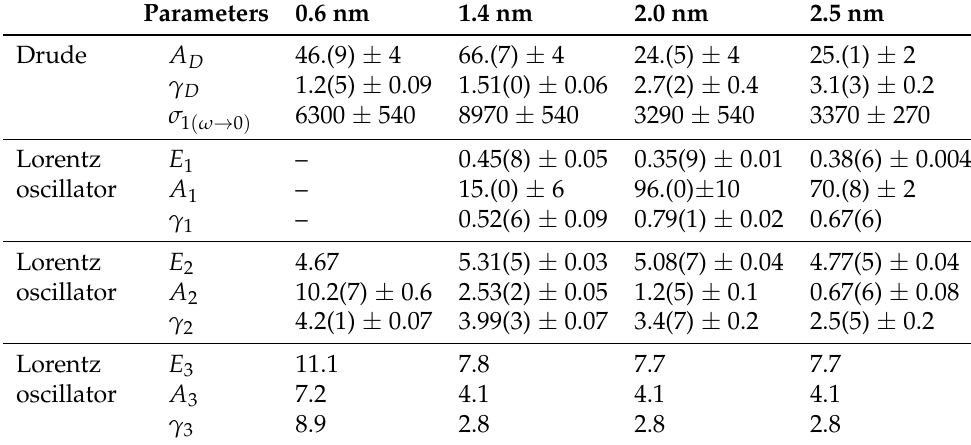
Table 1. Drude–Lorentz parameters for the Bi spacer layer in the [Bi(0.6,1.4,2.0,2.5nm)–NiFe(1.8nm)] 16 - multilayered films obtained from the model simulations of the dielectric functions by using Equation (1). The values of E j , γ j , and γ D are given in eV and optical conductivity limit σ 1 ( ω → 0 ) in Ω − 1 · cm − 1 .